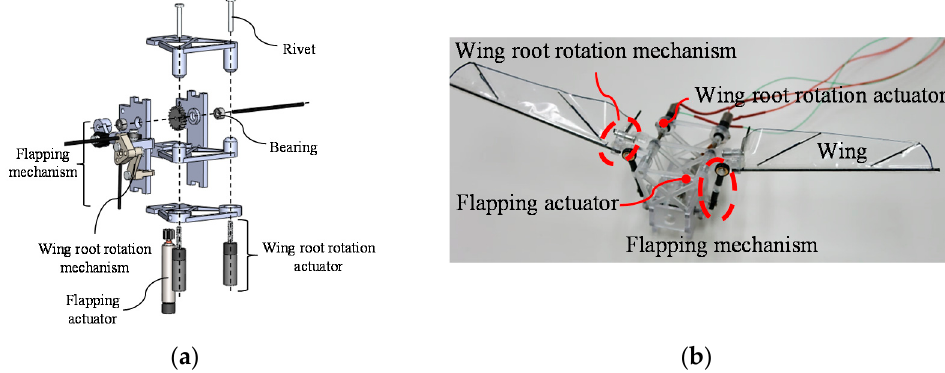
Figure 13. ( a ) Designed prototype and ( b ) front view of fabricated prototype.